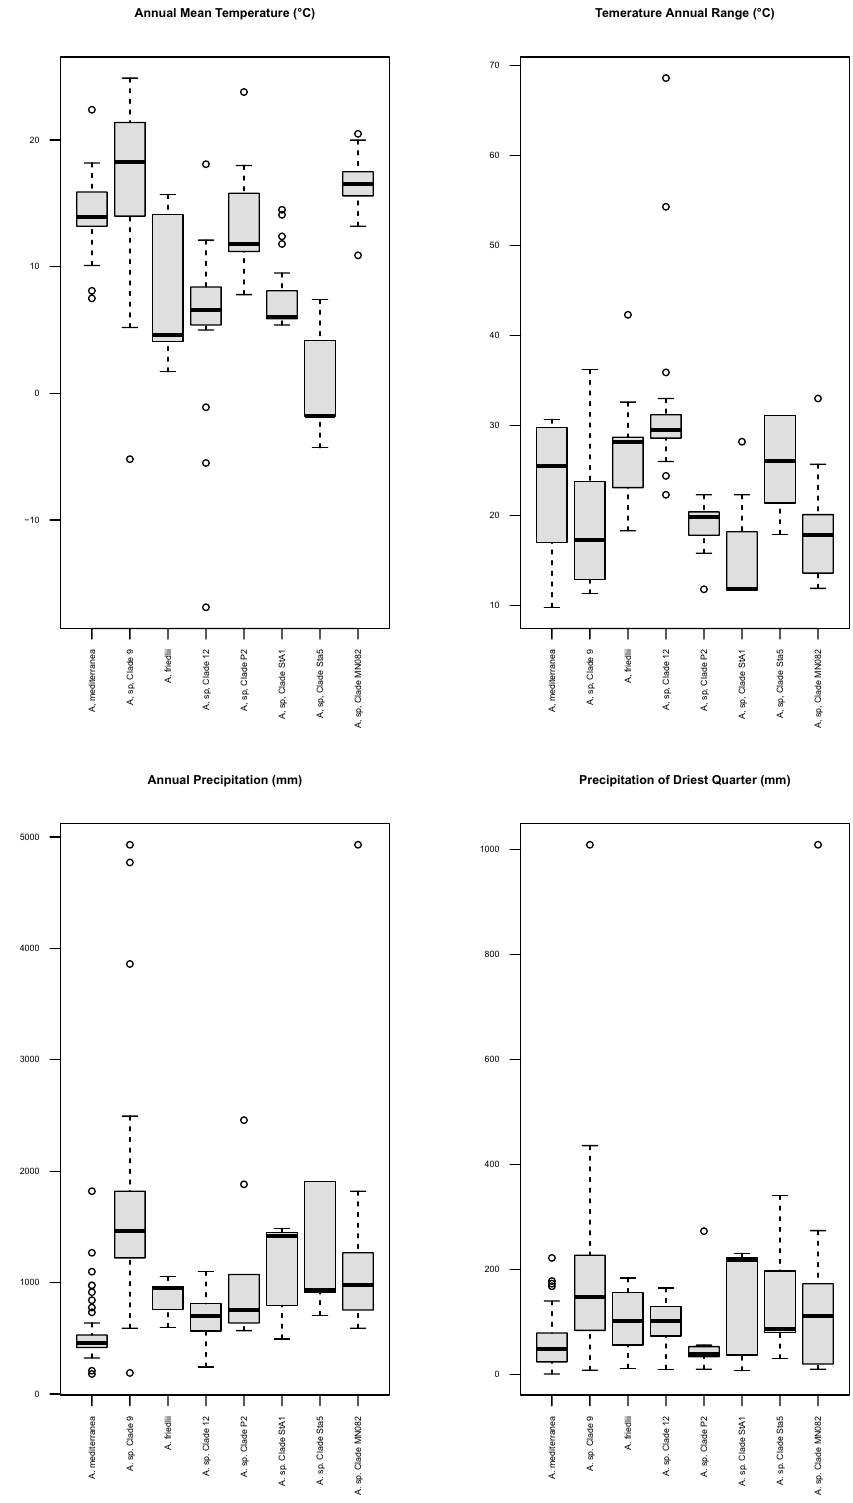
Figure 2. Box-plot diagram representing differences in climatic preferences for selected species and lineages of Asterochloris photobionts. Climatic data were obtained from the Global Climate Data—WorldClim. BIO1 = Annual Mean Temperature (°C), BIO7 = Temperature Annual Range (°C), BIO12 = Annual Precipitation (mm), BIO17 = Precipitation of Driest Quarter